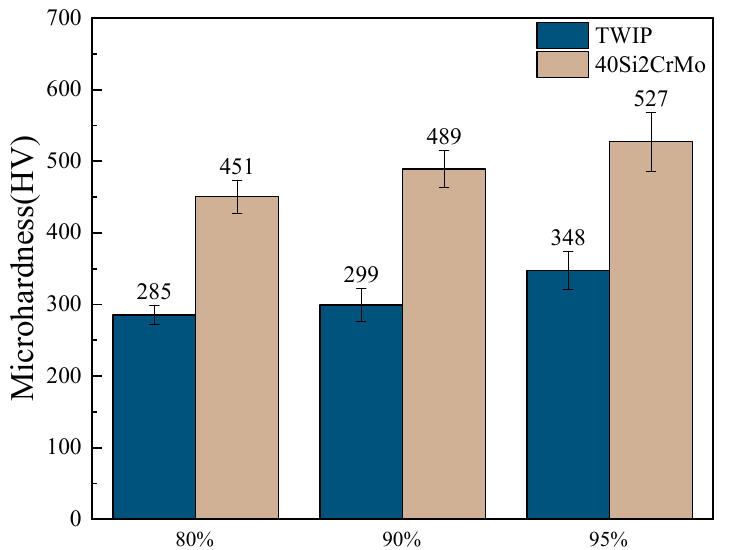
Figure 7. Microhardness values of multilayer TWIP/40Si2CrMo steels with different hot rolling re- ductions.